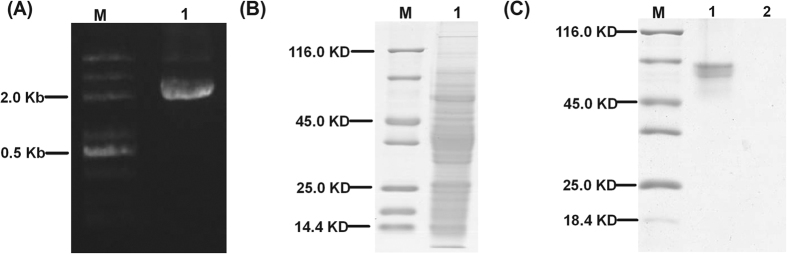
DNA-pull down screening of the interacting proteins on the promoter of Os10g0167600.The biotin-labeled DNA fragment of the promoter of Os10g0167600 was mixed with the leaf total natural protein to catch the interacted proteins. The mixture was immobilized with streptavidin-coupled beads and then eluted with 1 M NaCl and forwarded to SDS-PAGE. (A) gene fragment of the promoter of Os10g0167600, M, 100 bp DNA ladder, lane 1, promoter of Os10g0167600; (B) the leaf total natural proteins of Lemont, M, protein ladder, lane 1, leaf total natural proteins; (C) the interacted protein on the promoter of Os10g0167600. M, protein ladder, lane 1 shows the proteins interacting with the DNA fragment of the promoter of Os10g0167600, lane 2 shows the negative control in which the DNA fragment is mixed with the protein extracting solution.